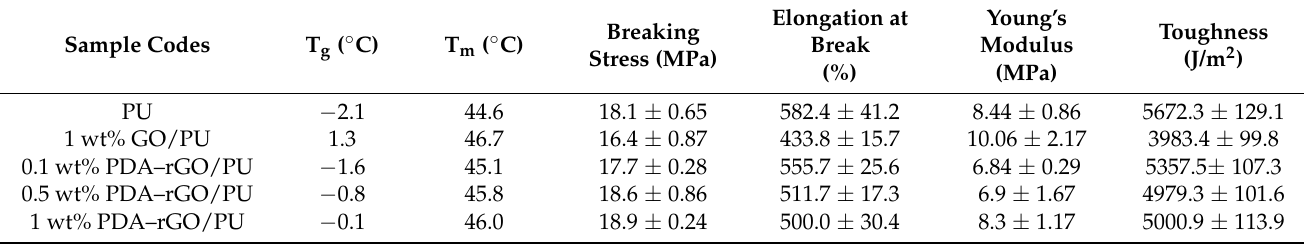
Table 1. Thermal and mechanical properties of PU and PU